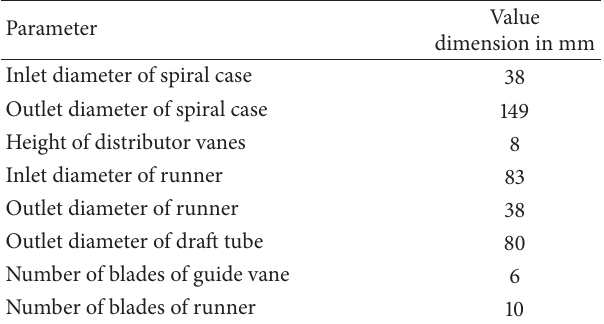
Table 1: Geometrical parameters of Francis turbine